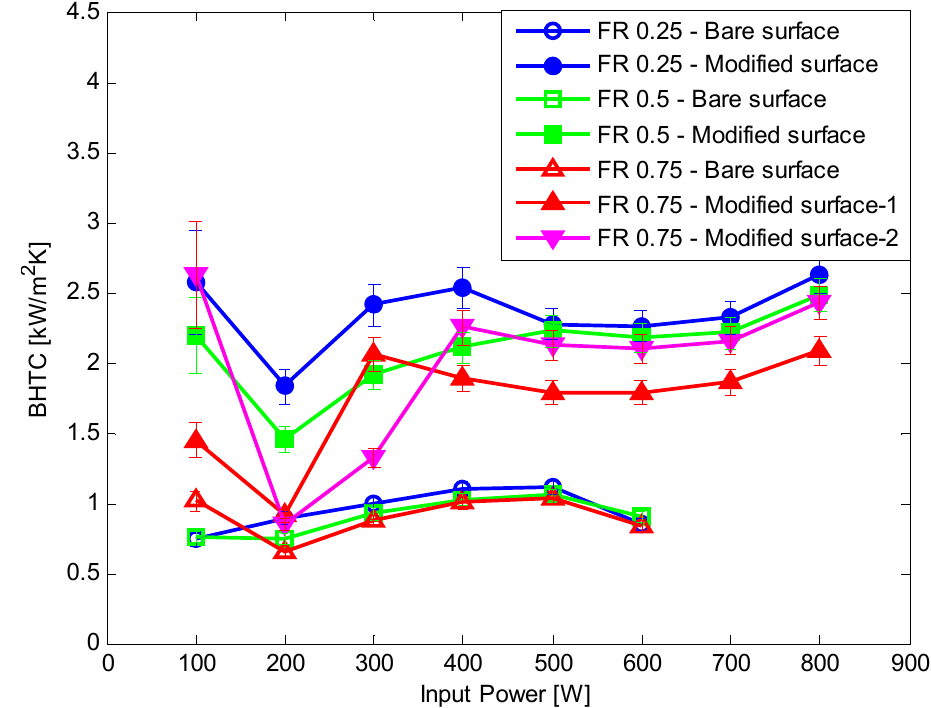
Figure 8. Comparison of the boiling heat transfer coefficient of bare and hydrophilic surfaces.